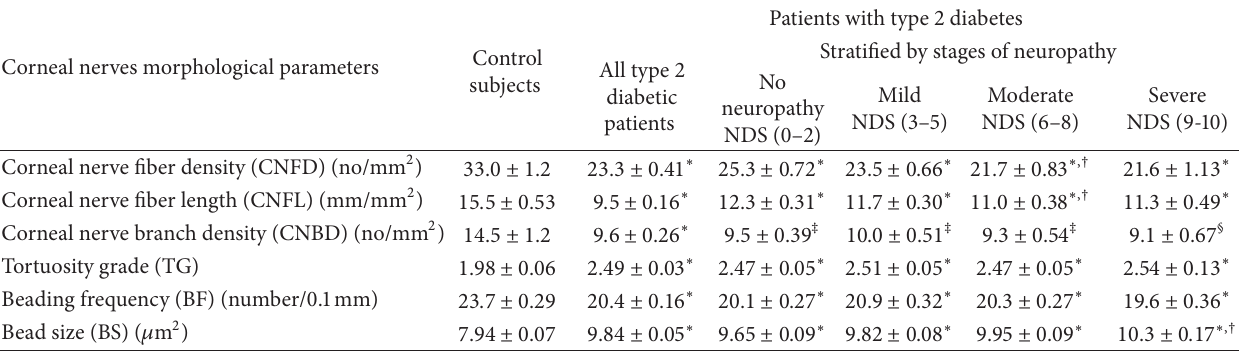
Table 2: Summary of corneal nerves morphological parameters in control subjects, type 2 diabetic patients, and their subgroups stratified by the stages of neuropathy.